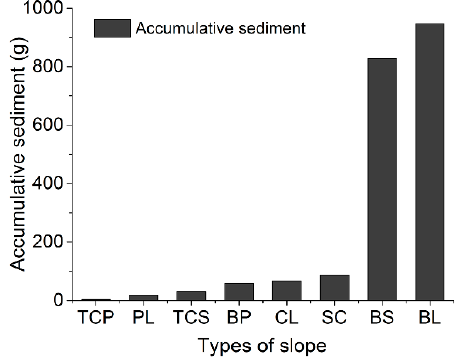
Figure 8. Accumulative sediment yields under different slope treatments.